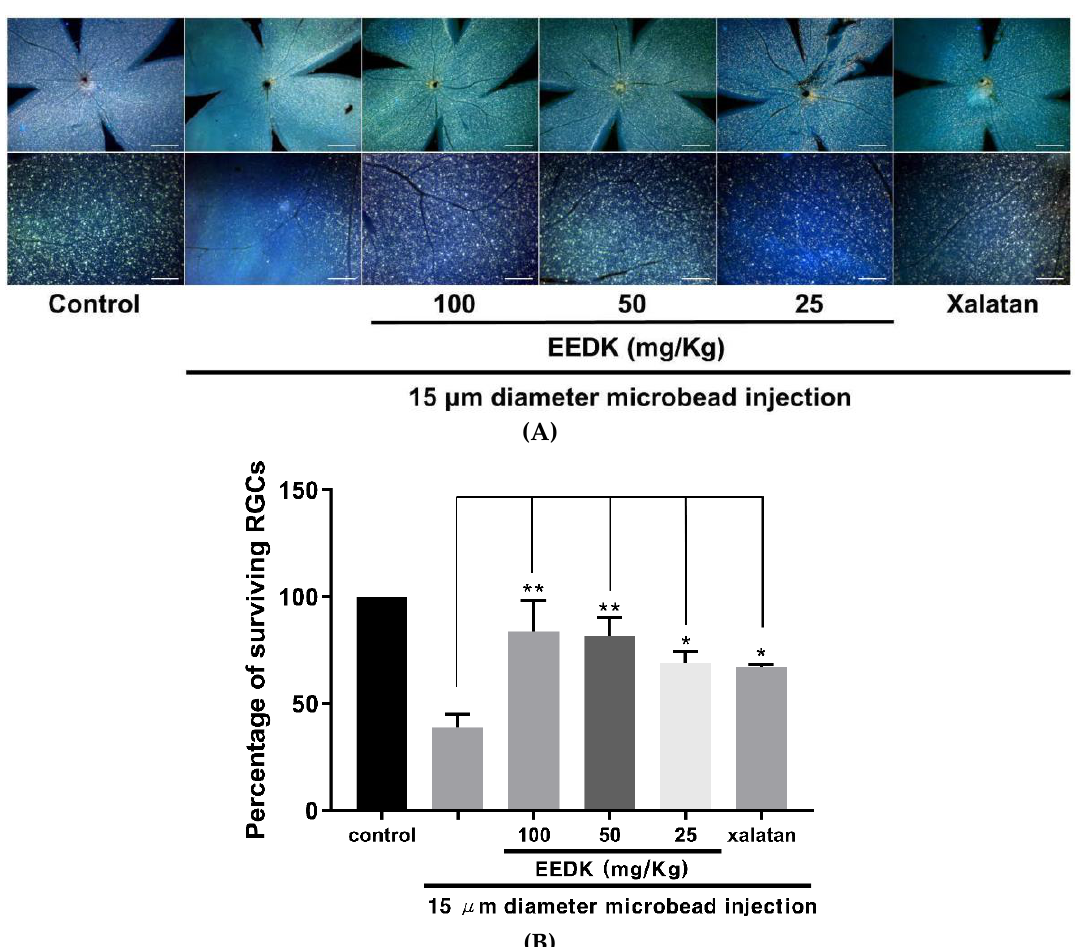
Figure 2. Effect of EEDK on RGCs survival in microbeads-induced OHT mice. ( A ) Representative fluorescent images of retrograde-labelled RGCs in microbeads-induced mice (Scale bars, upper panels: 500 μ m, lower panels: 100 μ m) ( B ) The bar graph shows quantitative analysis of the RGCs survival rate (%) compared with negative control. Values represent the mean ± S.E.M. for 3 animals (* p < 0.05, ** p < 0.01, mean ± S.E.M.).